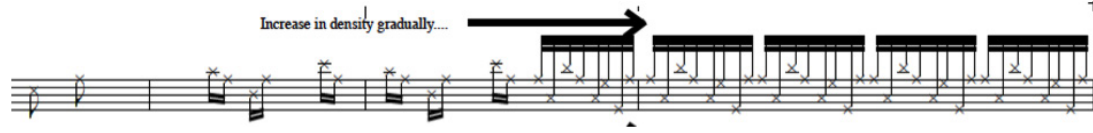
Figure 19. Gradual increase in density and speed and indeterminate